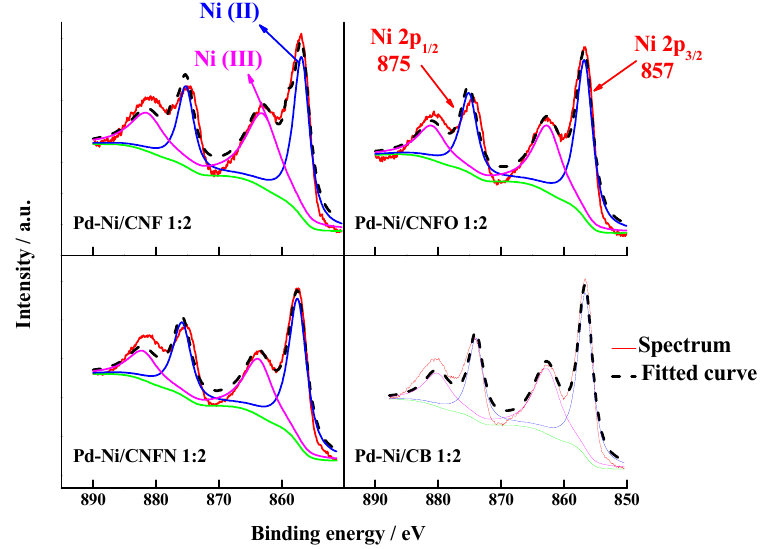
Figure 6. Ni 2p XPS spectra for the synthesized Pd ‐ Ni catalysts supported on carbon nanofibers and carbon black.